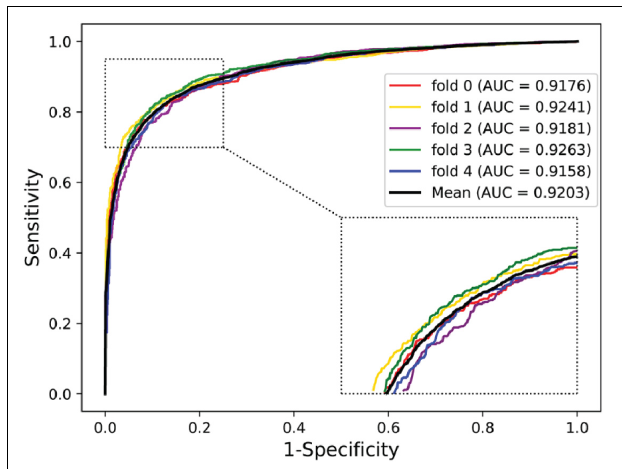
FIGURE 8 | ROC curves performed by the proposed model on yeast dataset.